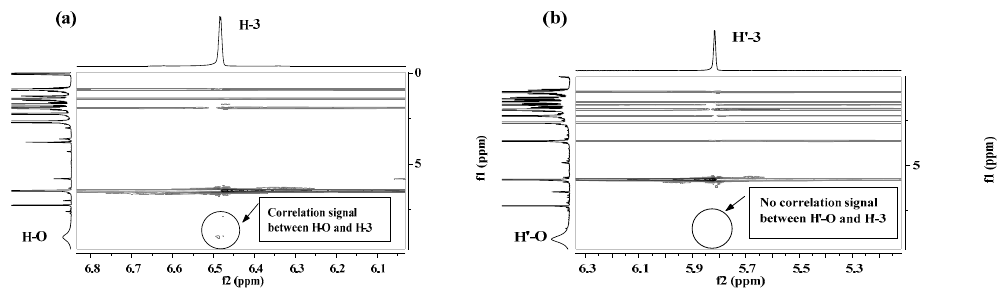
Figure 1. Expanded NOESY spectra of the ( Z )- and ( E )-verbenone oximes 3 , ( a ) ( E )-verbenone oxime; ( b ) ( Z )-verbenone oxime.